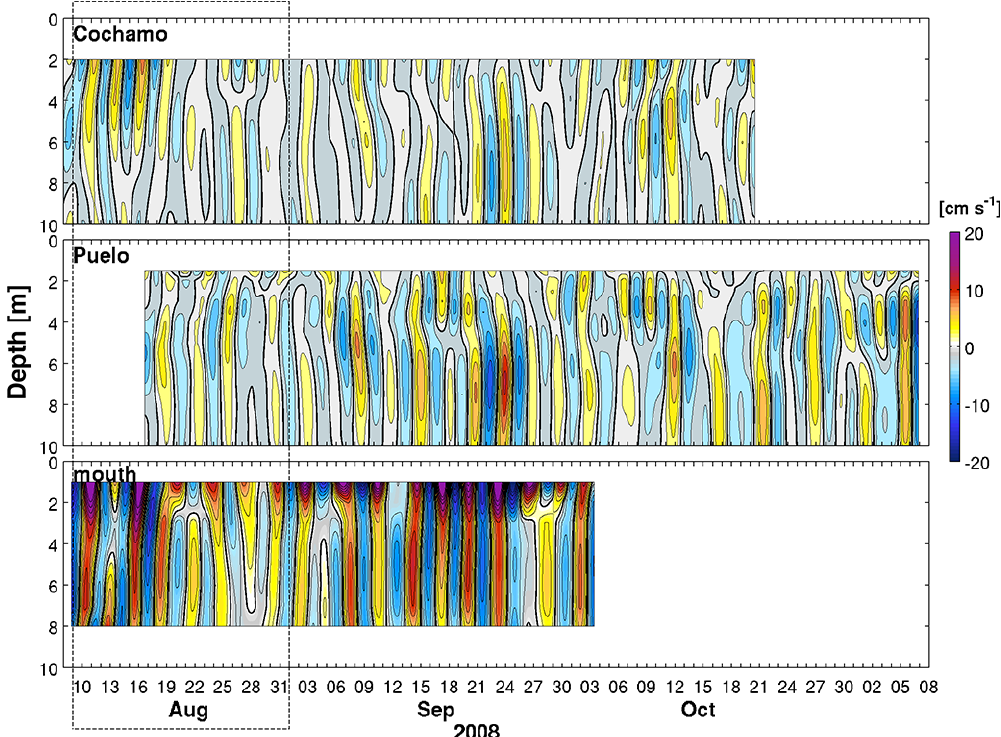
Figure 6. Band-passed along-fjord currents. Contours of band-passed (700–90h) along-fjord currents. Negative (positive) currents in blue (in red) imply an outflow (inflow). Note the dotted square at the middle of August: it is zooming on Fig. 9.